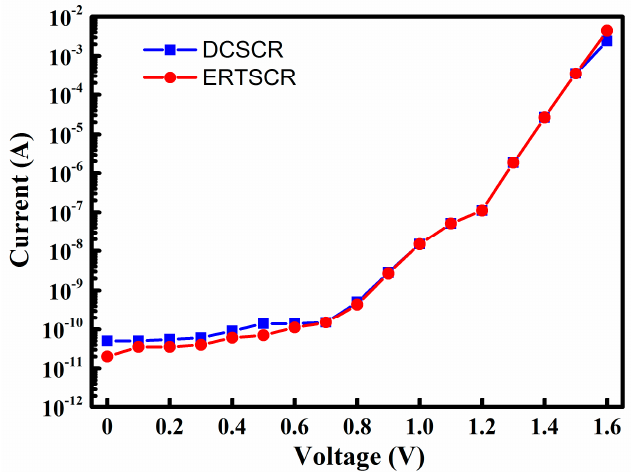
Figure 8. Measured leakage currents of conventional DCSCR and proposed ERTSCR.